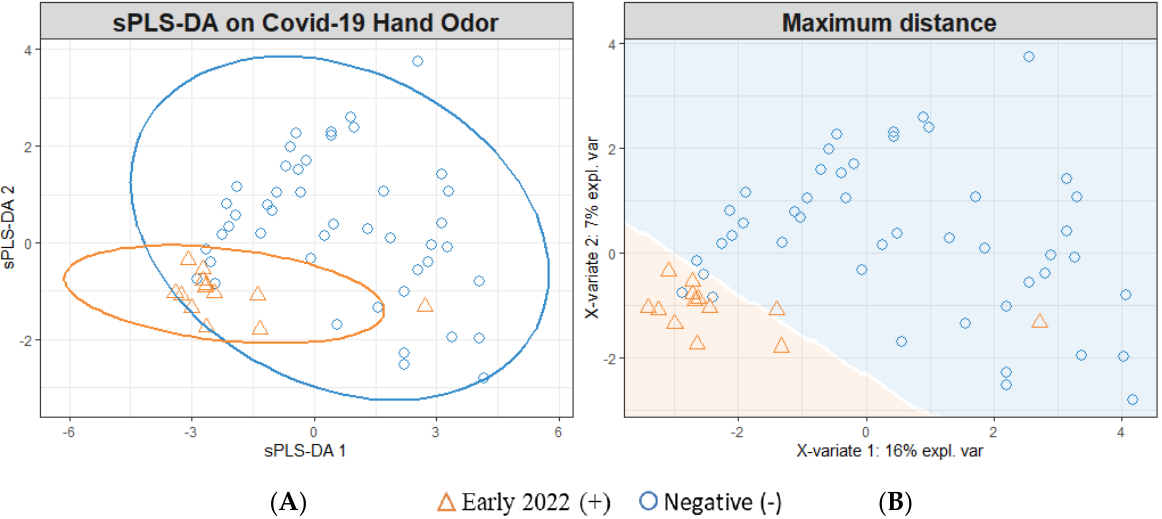
Figure 3. Early-2022 sPLS-DA Model; (+) Early-2022 Hand Odor Samples vs. ( − ) SARS-CoV-2 Samples. ( A ) Individual sample plot; ellipses = 95% CI. ( B ) Individual sample plot; background delineates class assignment.